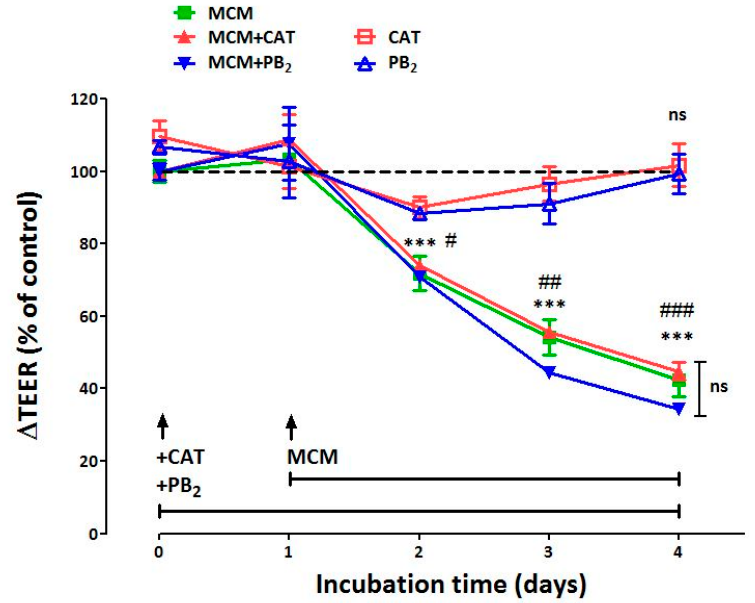
Figure 1. Trans-epithelial electrical resistance of Caco-2 / HT29-MTX monolayers. E ff ect of macrophage-conditioned medium. After a tight monolayer had formed, ( + )-catechin (CAT) and procyanidin B 2 (PB 2 ) (50 µ M) were added, where indicated, to the apical chamber (T0). After 24 h,